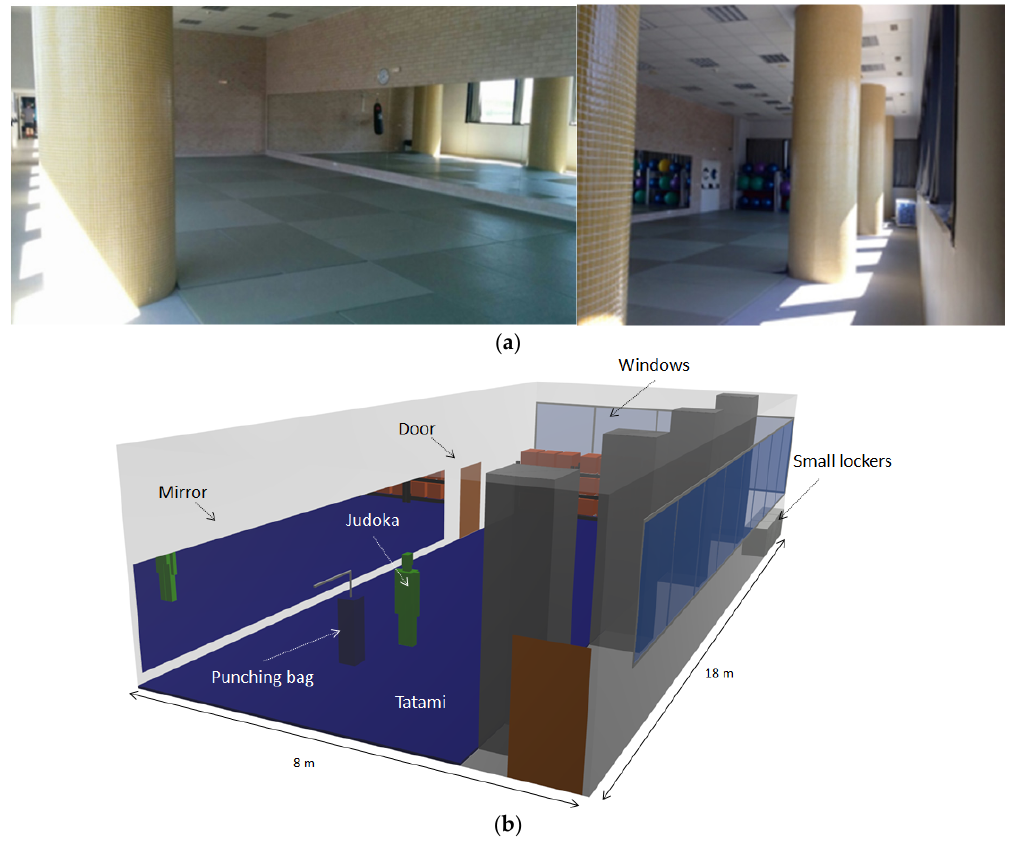
Figure 3. ( a ) Real scenario under analysis; ( b ) Schematic view of the created scenario for 3D ray launching simulations.